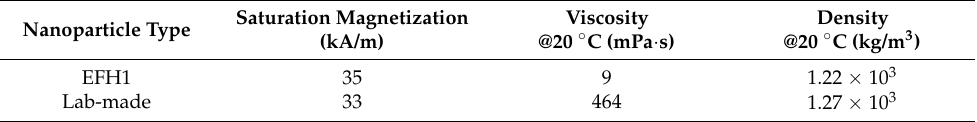
Table 1. Physical parameters of commercial and lab-made magnetic-fluid samples.